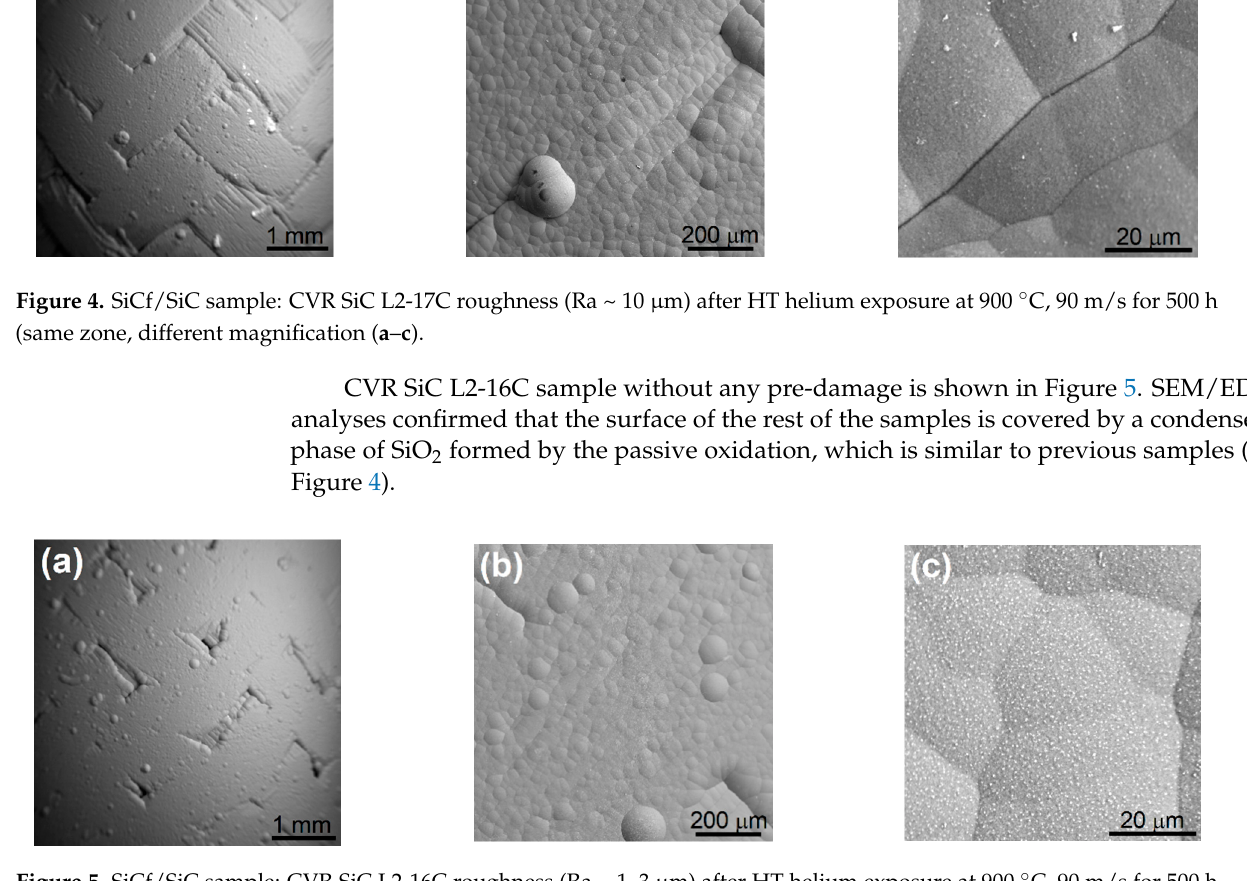
Figure 5. SiCf/SiC sample: CVR SiC L2-16C roughness (Ra ~ 1–3 μ m) after HT helium exposure at 900 °C, 90 m/s for 500 h (same zone, different magnification) ( a – c ).